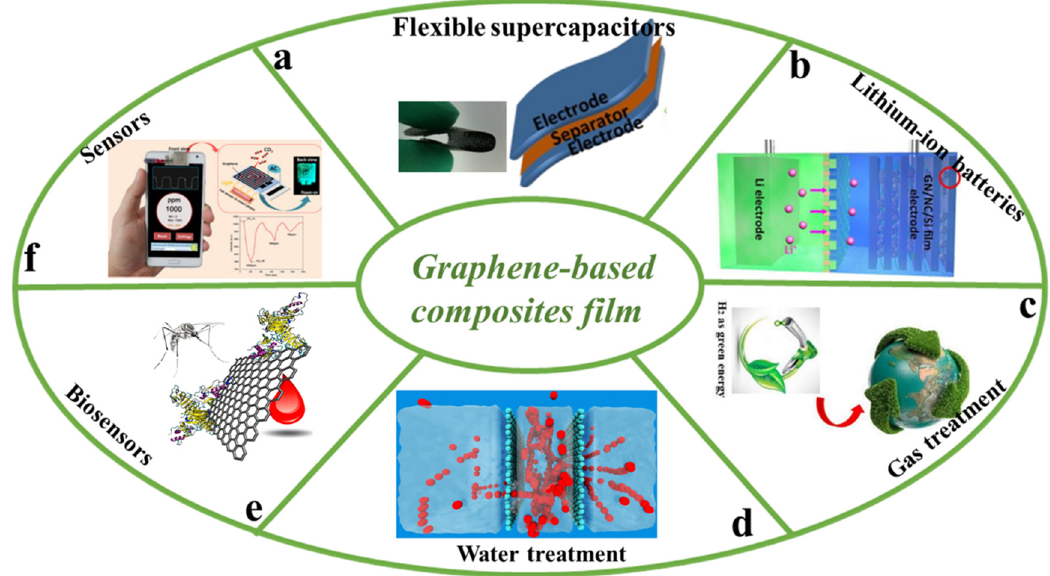
Figure 12. Applications of the graphene-based film. ( a ) Flexible graphene-based composite films for Supercapacitors. Reprinted with permission from ref. [100] Copyright 2017, Elsevier. ( b ) A free-standing sandwich-type GN/NC/Si Laminar Anode for flexible rechargeable Lithium-ion batteries. Reprinted with permission from ref. [102] Copyright 2018, American Chemical Society. ( c ) High-performance graphene oxide (GO) nanocomposite membrane for hydrogen separation. Reprinted with permission from ref. [105] Copyright 2014, American Chemical Society. ( d ) Multilayer nanoporous graphene membranes for water desalination. Reprinted with permission from ref. [107] Copyright 2016, American Chemical Society. ( e ) Novel graphene-based biosensor for early detection of Zika virus infection. Reprinted with permission from ref. [109] Copyright 2018, Elsevier. ( f ) Graphene-based electroluminescent gas sensor for CO 2 detection at room temperature. Reprinted with permission from ref. [111] Copyright 2019, Elsevier.